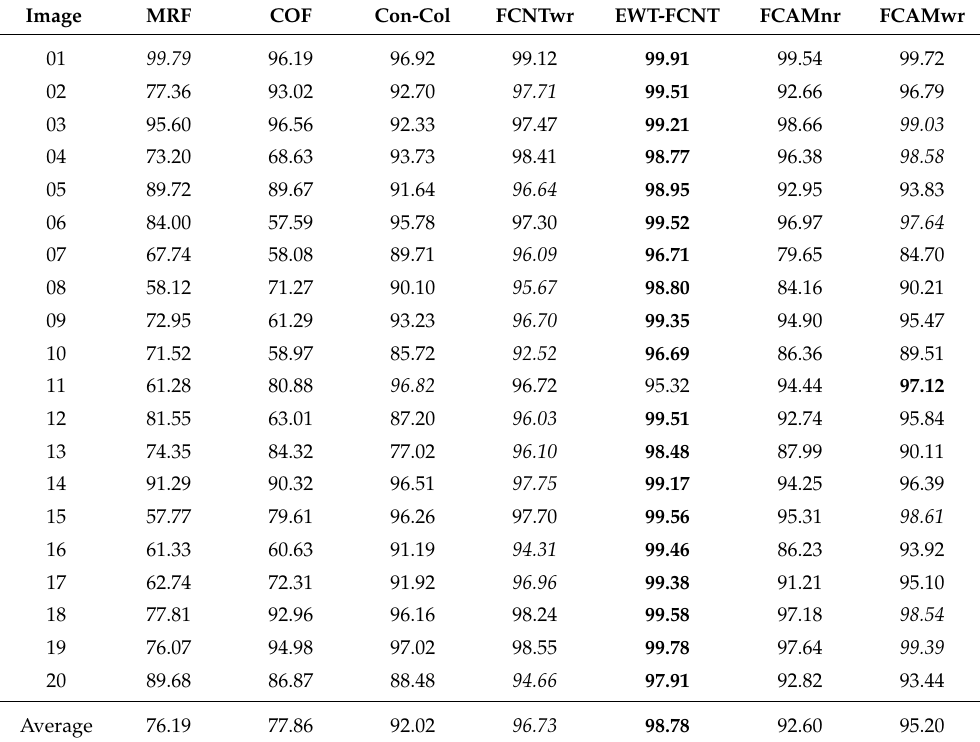
Table 4. Accuracy (CO) for each test image of the Prague dataset. “nr” means no segmentation refinement, and “wr” means with segmentation refinement. Best results are in bold, and the second best ones in